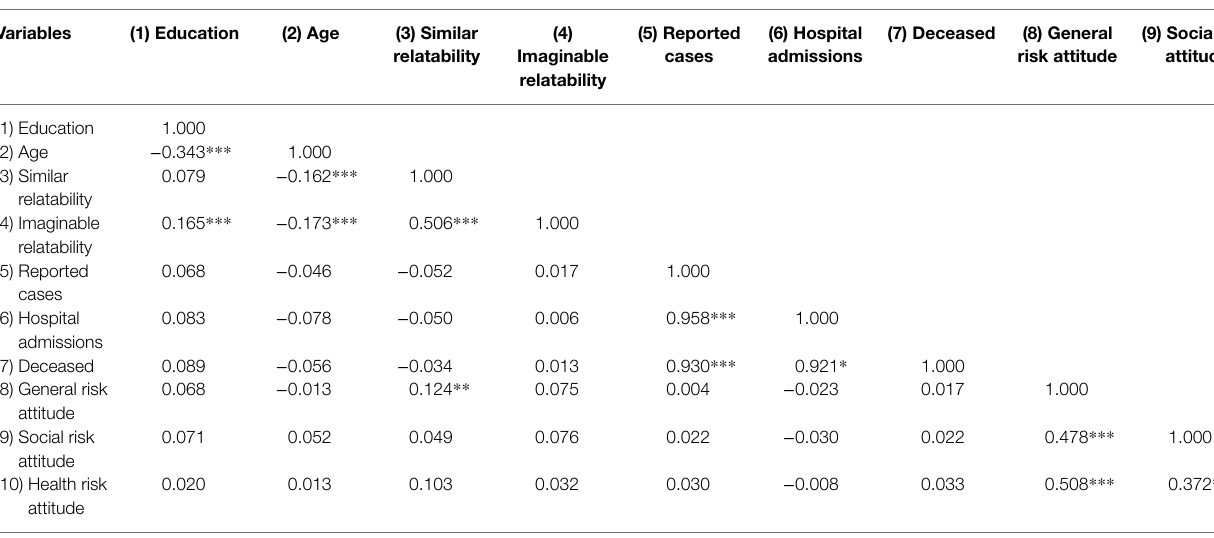
TABLE 2 | Pairwise correlations of independent